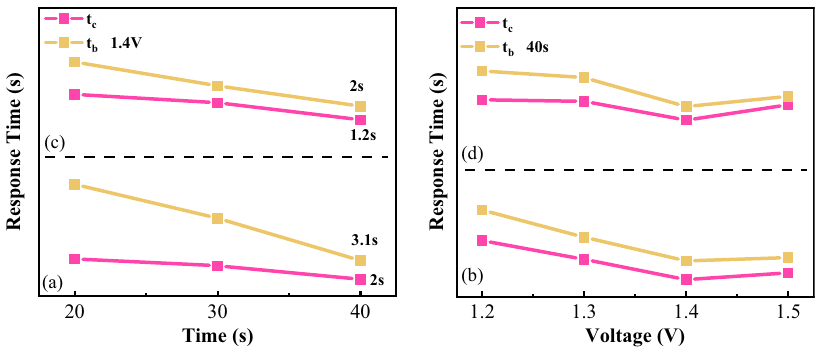
Figure 8: Response time of ( a ) PEDOT:PSS fi lms deposited at 1.4 V for di ff erent times, ( b ) PEDOT:PSS fi lms deposited at di ff erent voltages for 40 s, ( c ) PEDOT:PSS/EMI - TFSI fi lms deposited at 1.4 V for di ff erent times, and ( d ) PEDOT:PSS/EMI - TFSI fi lms deposited at di ff erent voltages for 40 s.